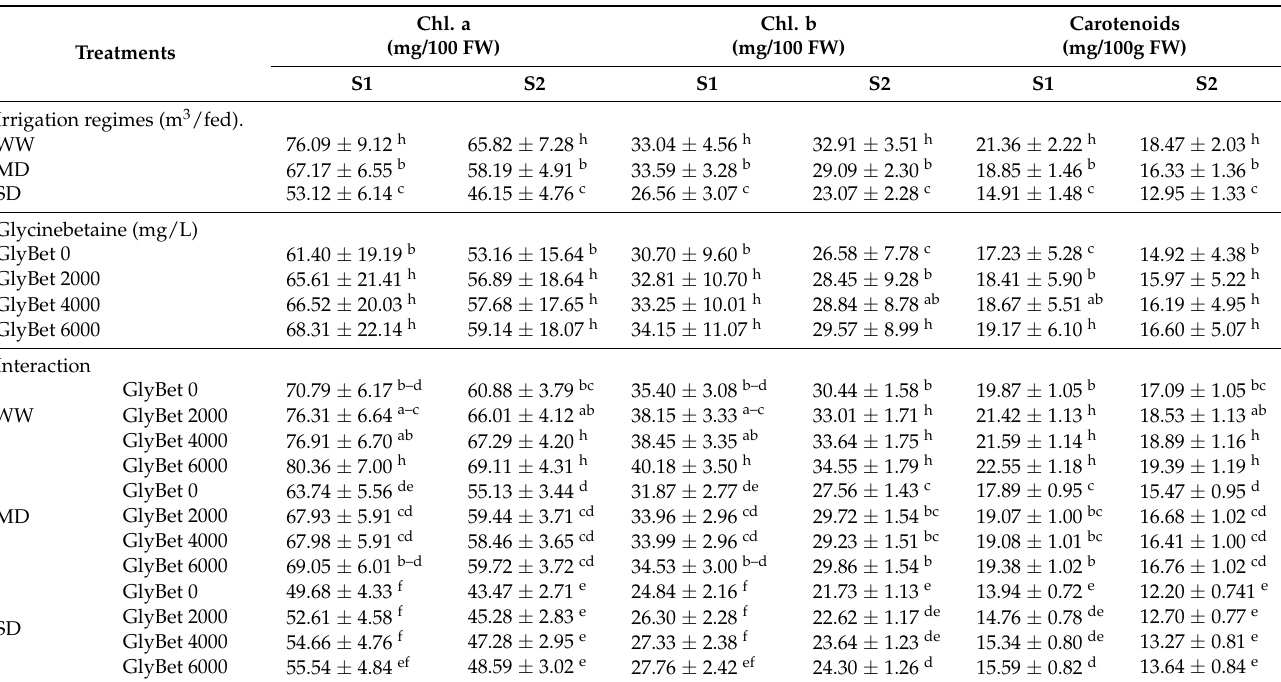
Table 3. Photosyntheic pigment concentration of cucumber plant as affected by GlyBet concentration, irrigation regimes and their interactions at 35 days from sowing in both season 2020 and